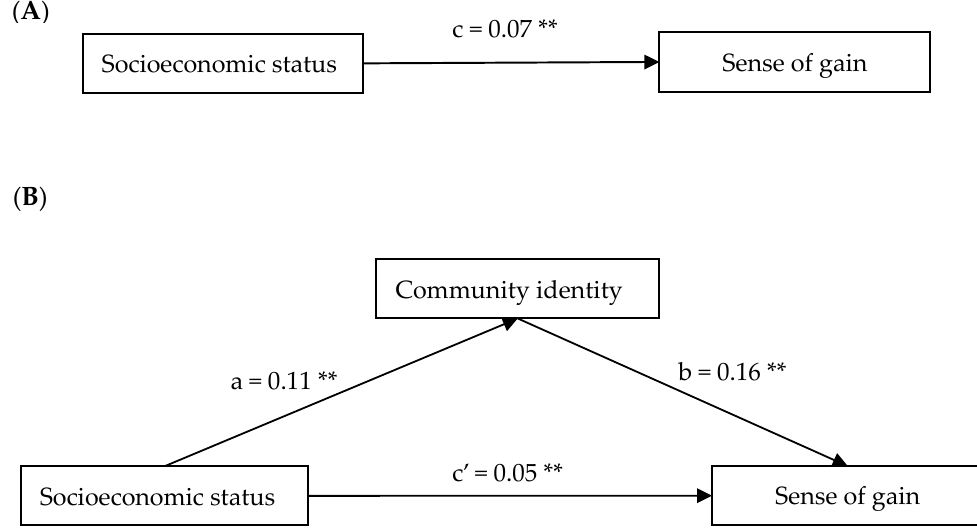
Figure 2. Tests of the theorized mediation model. ( A ) The total e ff ect (socioeconomic status predicting sense of gain). ( B ) The indirect e ff ect (with community identity as mediator). Indirect e ff ect, a × b ( β ) = 0.02, p < 0.01. Standardized regression coe ffi cients are displayed. * p < 0.05, ** p < 0.01.